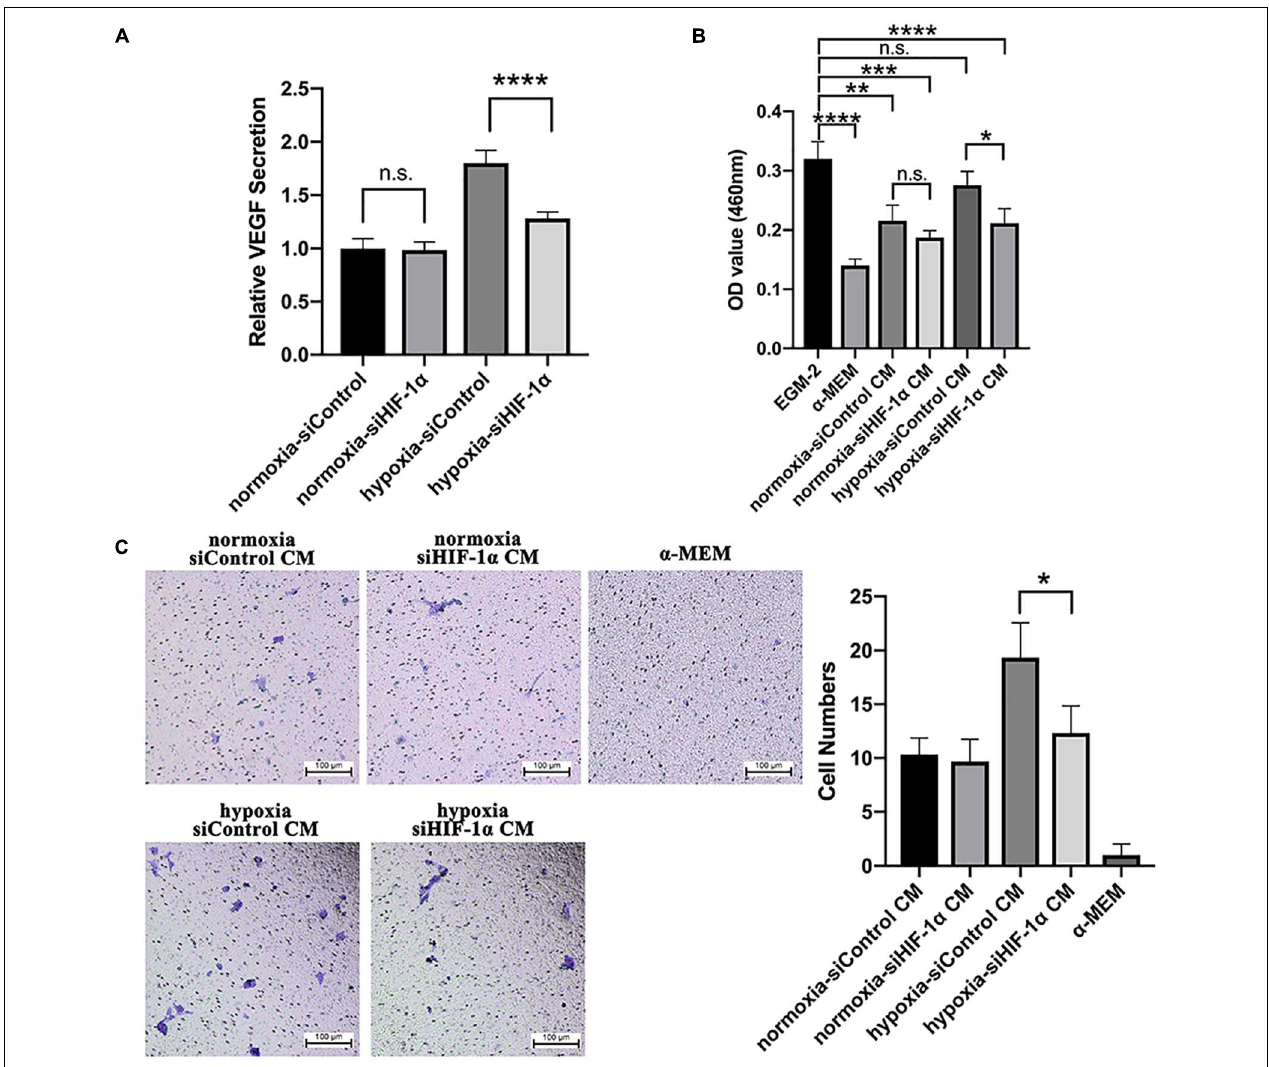
FIGURE 6 | Silencing of HIF-1 α in SHED reduced VEGF secretion and paracrine effects on HUVECs. (A) VEGF levels in different conditioned media as detected by ELISA and normalized to that of siControl under normoxia. (B) CCK-8 assay of HUVECs cultured in different conditioned media, EGM-2 (positive control), α -MEM (negative control). (C) Trans -well assay of HUVEC migration under different conditioned media, α -MEM (negative control). * p < 0.05, ** p < 0.01, *** p < 0.001, and **** p < 0.0001. Scale bar = 100 µ